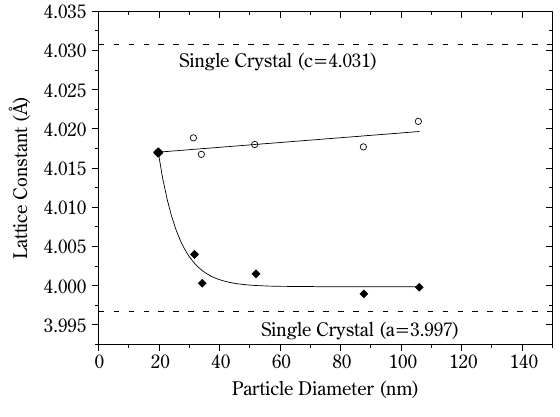
der the conditions of Z(YY)Z, X(ZZ)X and X(ZY)X, respectively. Here, a sharp peak was obseved at 308 cm (cid:3) 1 when measured under the condition of The lattice constant with particle